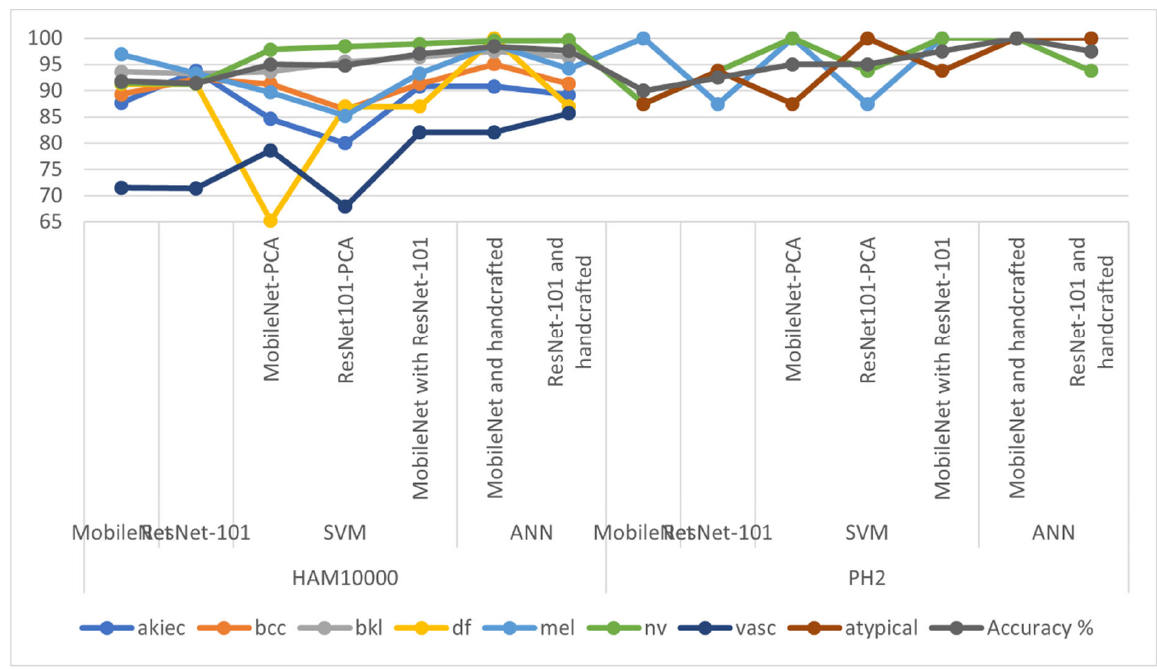
Figure 16. Display of the systems’ performance of dermoscopic image analysis for the classification of two datasets, HAM10000 and PH2, for skin lesions.